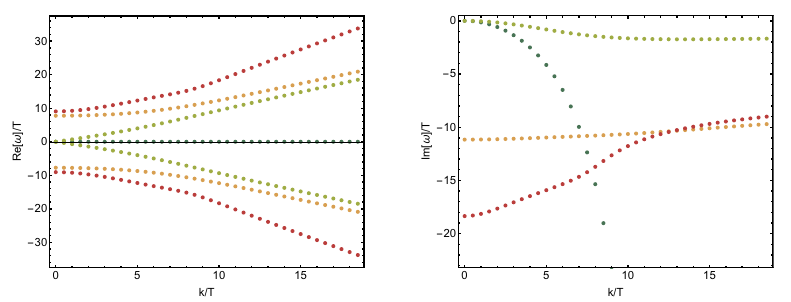
Figure 14 . The modes in the longitudinal sector of model (4.1) for m=T = 0 :